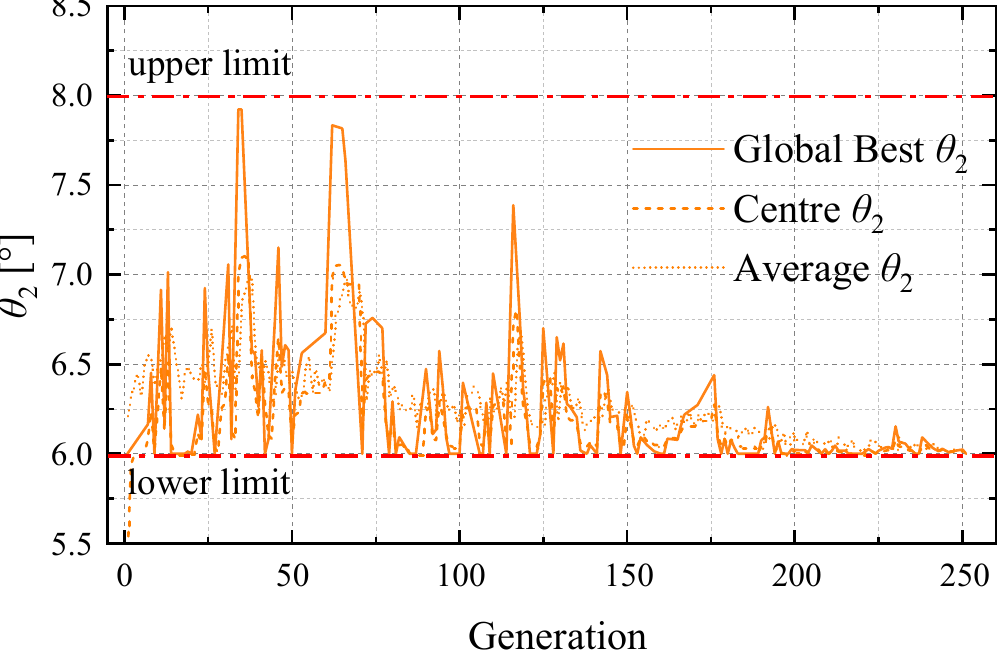
Figure 17. The convergence progress of inclination of exit straight segment: θ 2.